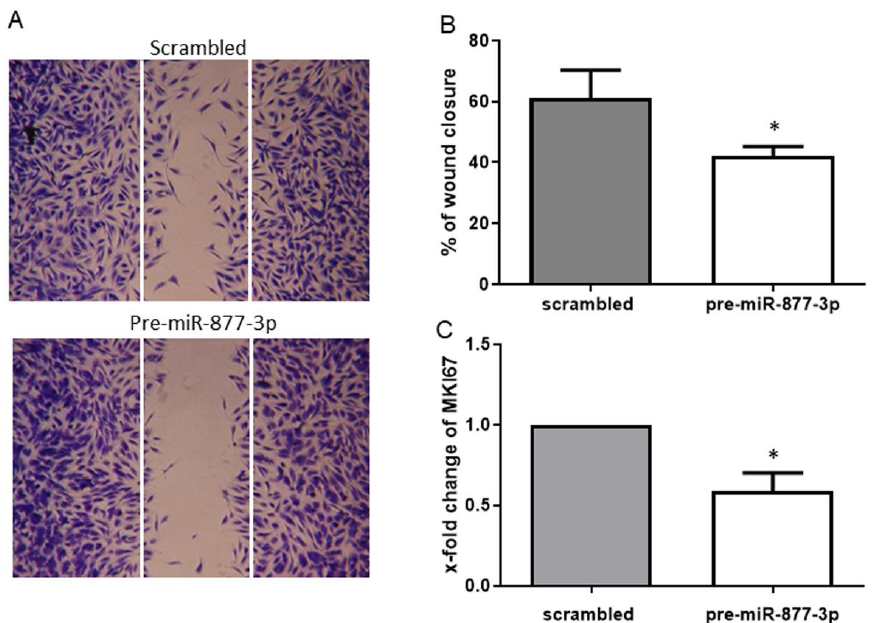
Figure 4. The overexpression of miR-877-3p inhibited the migration and proliferation of RA-FLS. ( A ) representative light microscopy images of RA-FLS. FLS monolayers 24 h after wounding are shown. ( B ) cell migration was analyzed for 24 h ( n = 4). ( C ) expression of MKI67 in pre-miR-877-3p-transfected RA-FLS ( n = 4). Values are means ± SD. * p < 0.05 vs. scrambled controls.